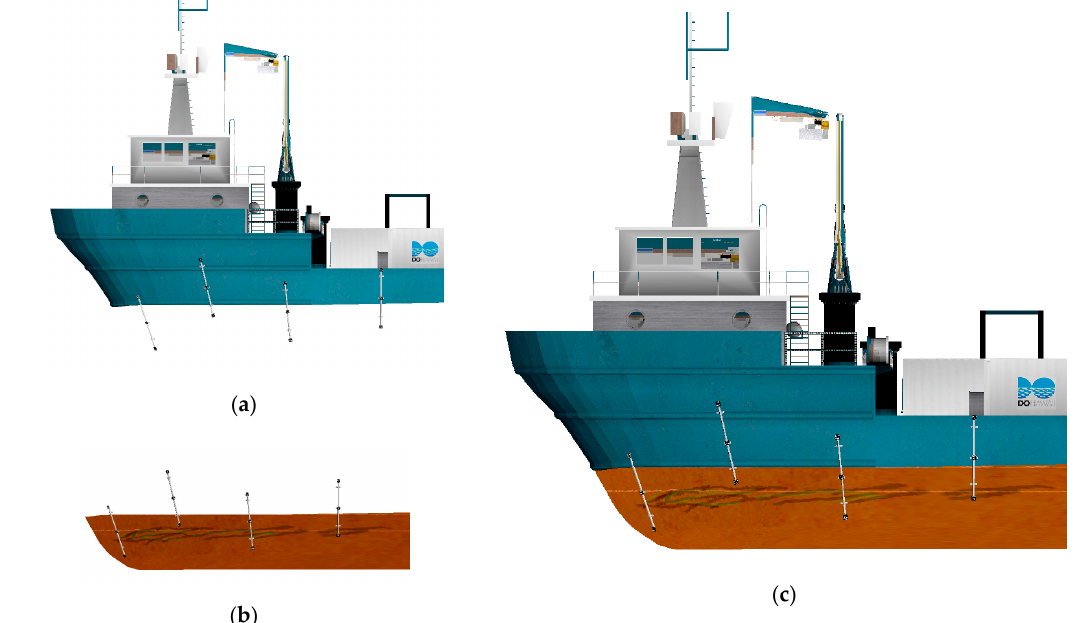
Figure 3. Example of application of method 1 to the two photogrammetric surveys carried out above the water ( a ), and below the water ( b ) with the final 3D merged model ( c ).